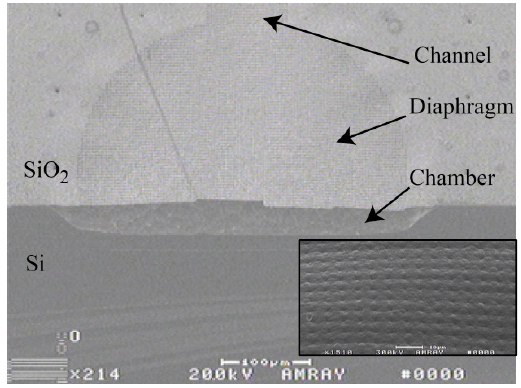
Figure 6. SEM of in-situ formed Parylene-C encapsulated TEOS diaphragm over a micropump chamber. Inset : Close-up of diaphragm visualizing dimples in the Parylene-C surface corresponding to the etched holes in the underlying TEOS